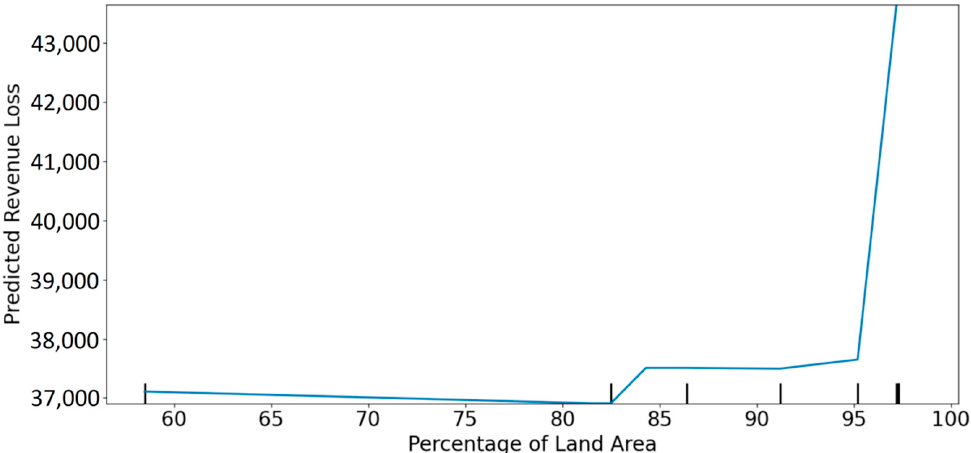
Figure 23. Influence of land area percentage on revenue loss.